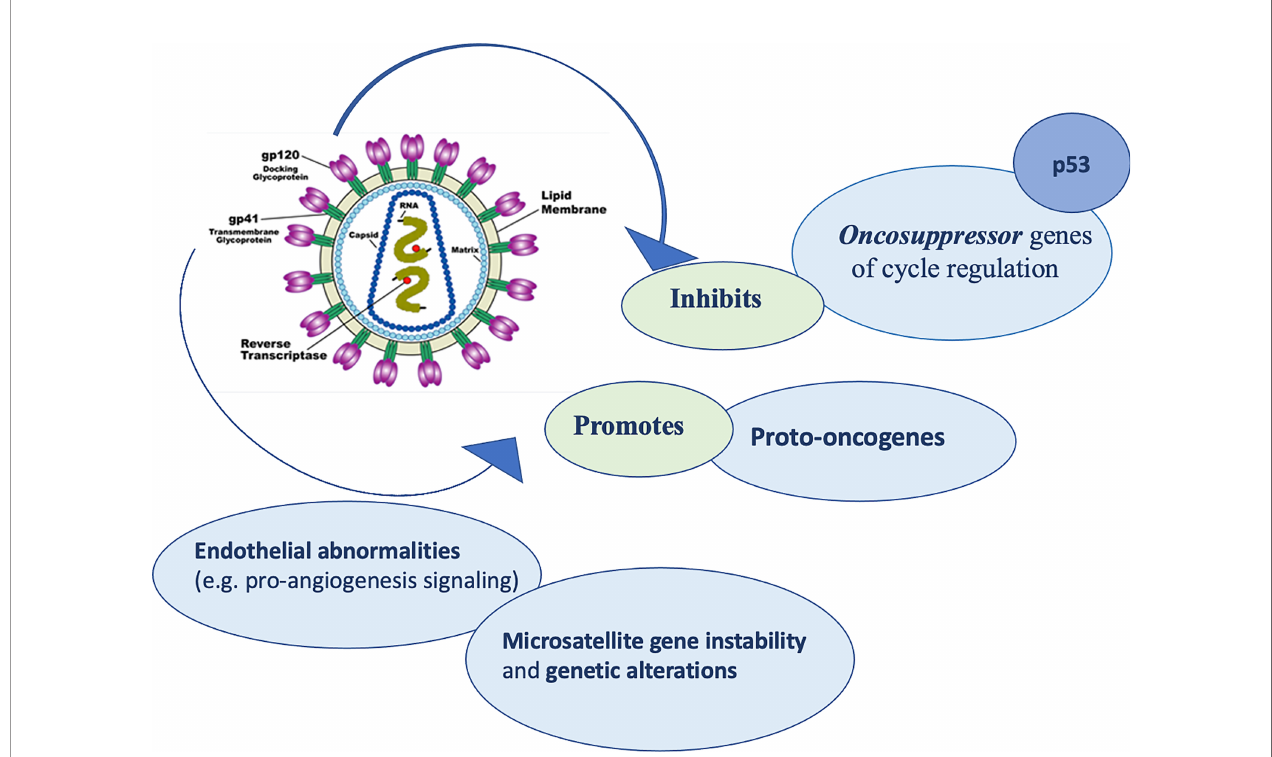
FIGURE 2 | The pathogenetic role of